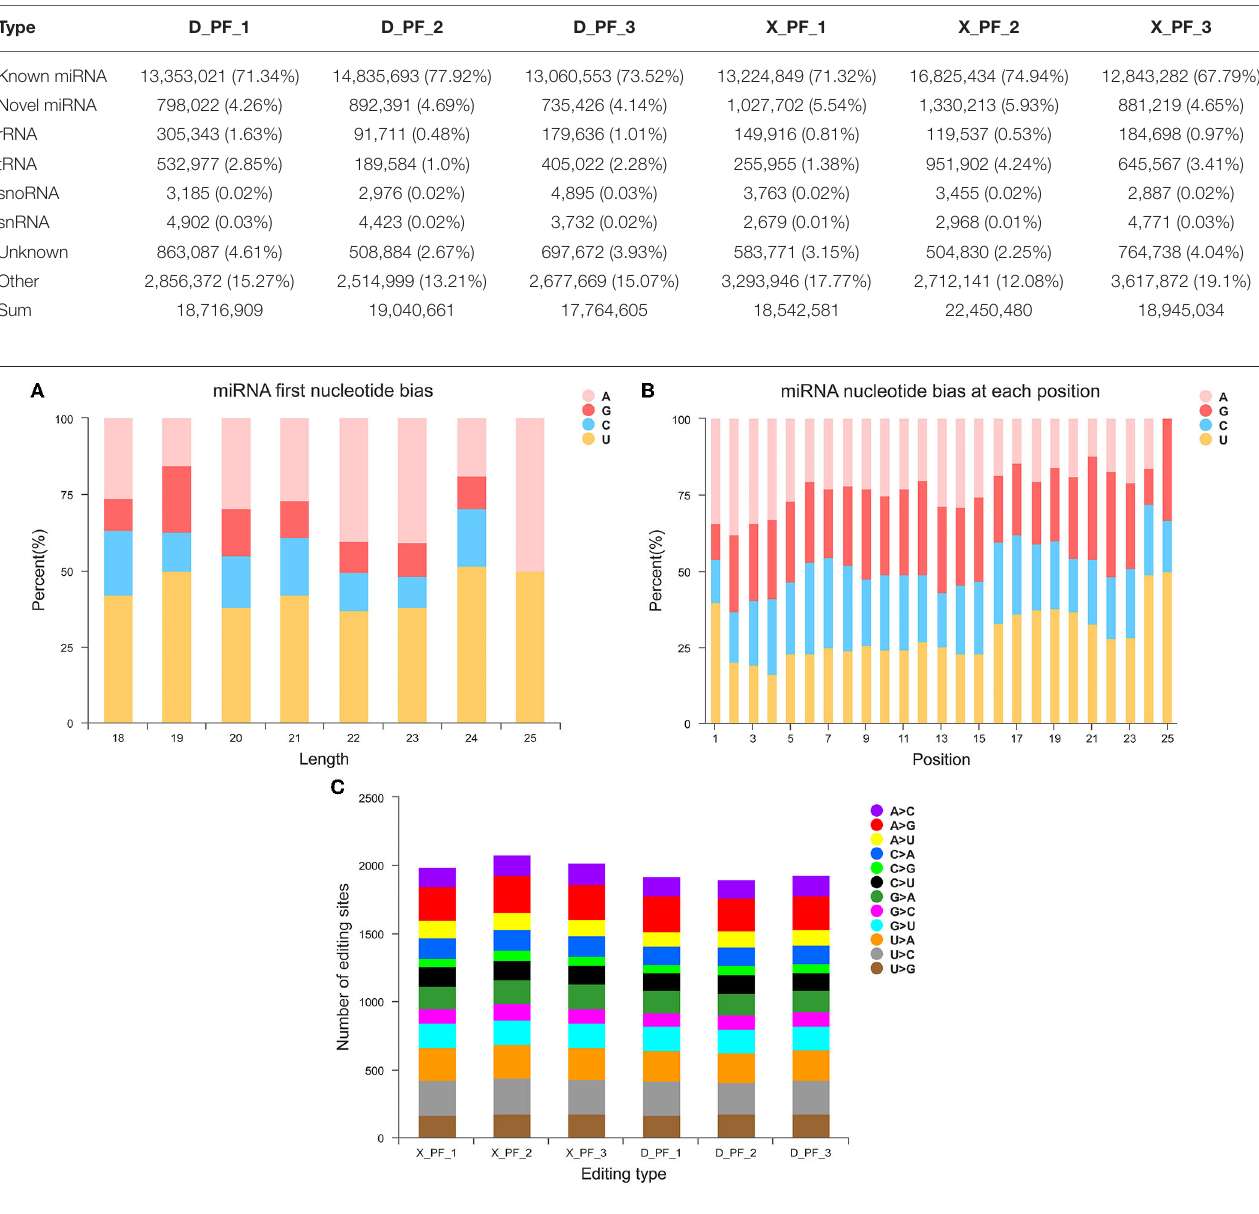
TABLE 3 | Small RNA classification statistics.